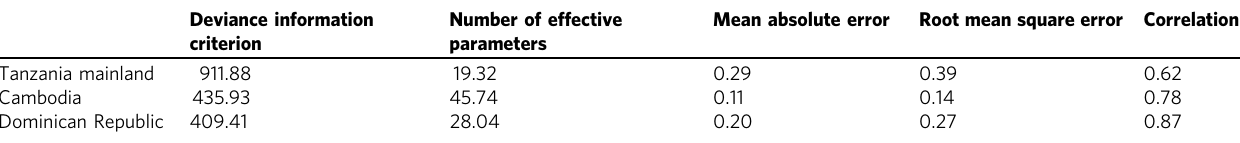
Table 1 Model goodness of fi t and prediction performance for Tanzania, Cambodia and the Dominican